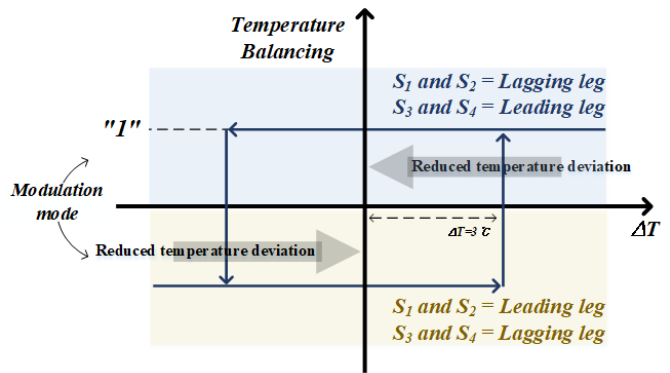
Figure 8. Hysteresis control of the temperature-balancing method.